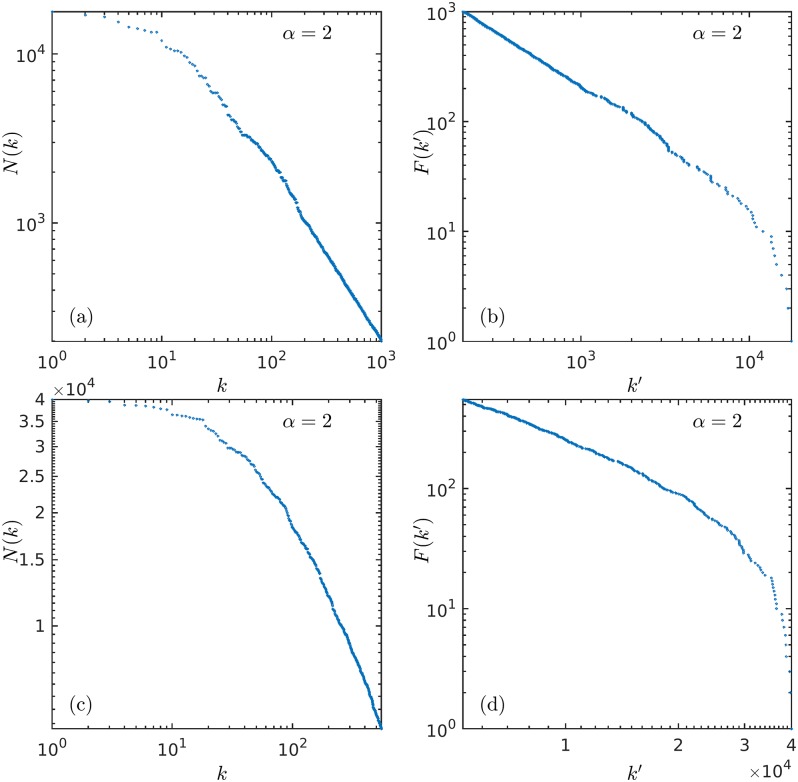
Two examples of ranked data.(a) Data for the energy released by earthquakes in California [14]. (b) Same earthquake data ranked according to number of occurrences of earthquakes of similar magnitude showing behavior compatible with the Guttenberg-Richter law. (c) Data for the areas burnt in forest fires in the U.S.A. [15]. (d) Same forest fires data ranked according to the number of occurrences of similar burnt areas. See text for description.